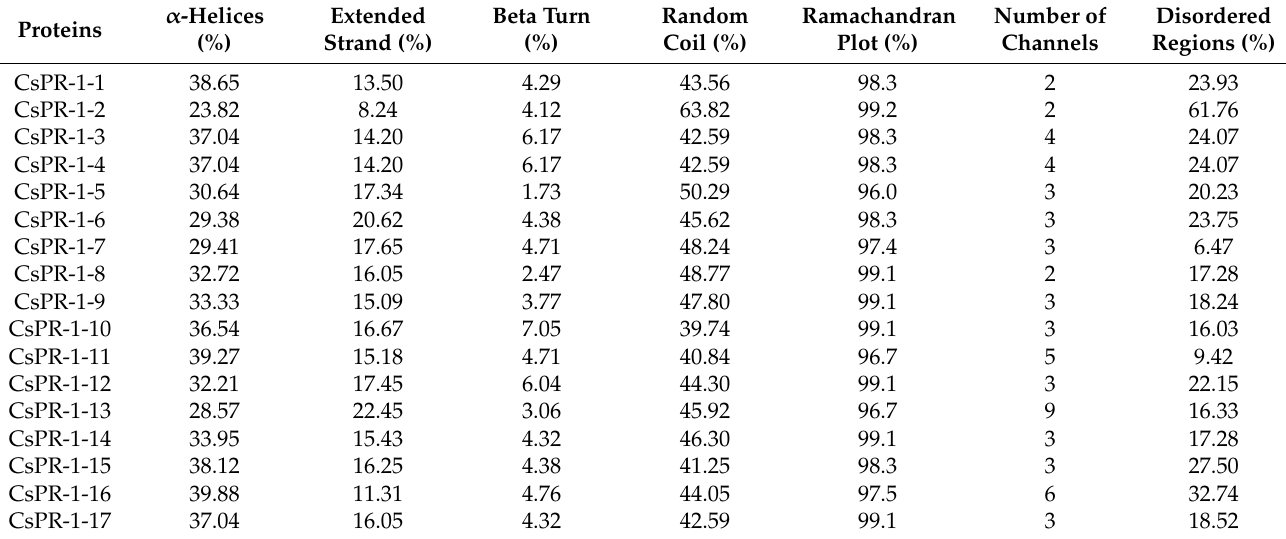
Table 2. Structural analyses of the CsPR-1